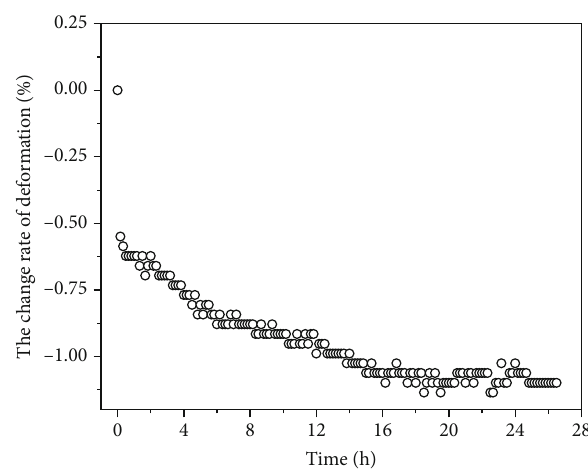
Figure 12: The change rate of deformation vs. time for soil